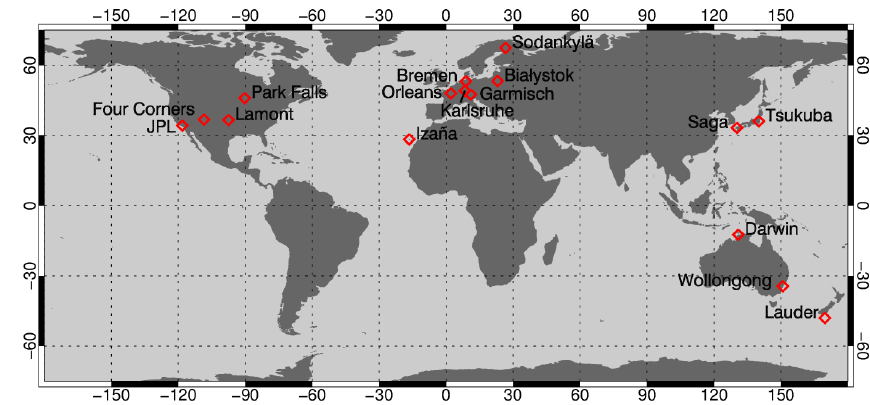
Figure 3. TCCON stations used for